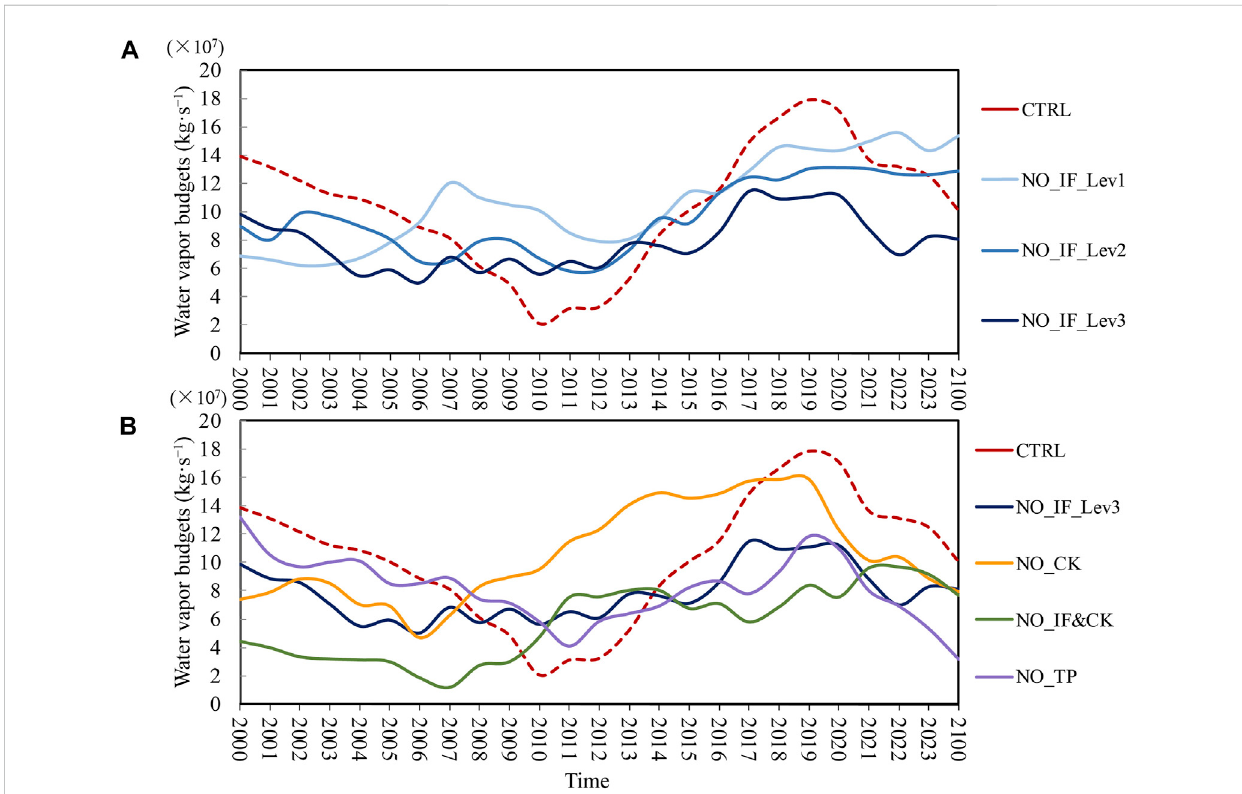
Time series of the vertically integrated water vapor fl ux (from the surface to 50 hPa, unit: 10 7 kg s − 1 , positive inward and negative outward) and budget (the sum of four boundaries of box in Figure 5E). (A) Comparison groups of NO_IF in Lev1-Lev3. (B) Comparison groups of CTRL, NO_IF_Lev3, NO_CK, NO_IF&CK, and NO_TP.